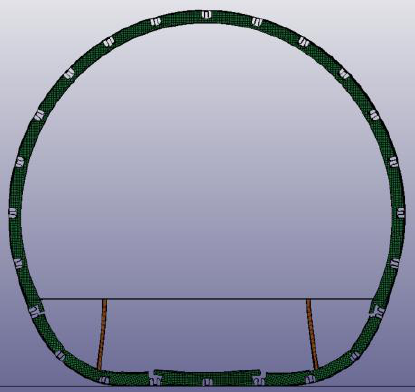
Figure 6: Aluminium fuselage after